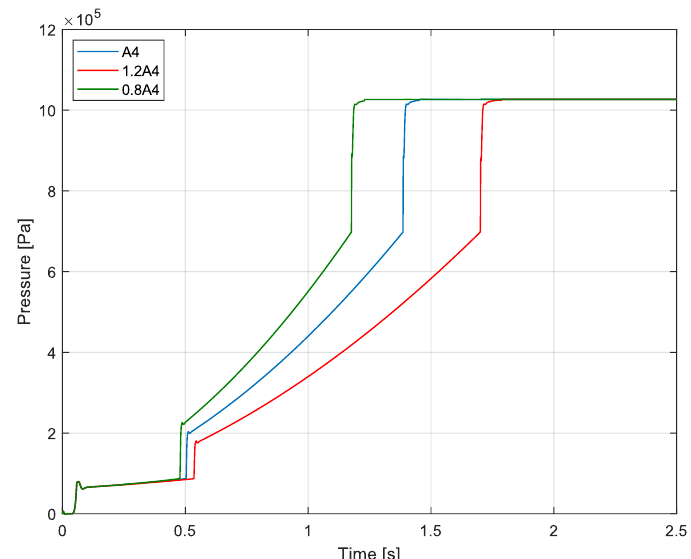
Figure 11 – Influence of the A 4 orifice surface (d) on the pressure modulation process Рис. 11 – Влияние поверхности отверстия A 4 (d) на процесс модуляции давления Слика 11 – Утицај површине A 4 прогушнице (d) на процес модулације